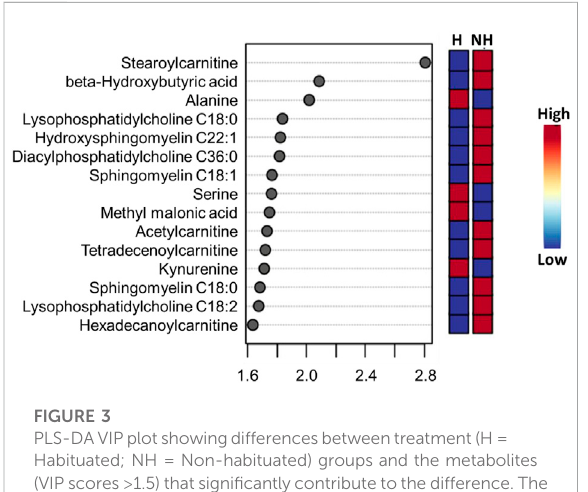
FIGURE 3 PLS-DAVIPplotshowingdifferencesbetweentreatment(H= Habituated; NH = Non-habituated) groups and the metabolites (VIP scores > 1.5) that signi fi cantly contribute to the difference. The metabolite concentrations averaged across all time points were used in the PLS-DA model ( p < 0.05).